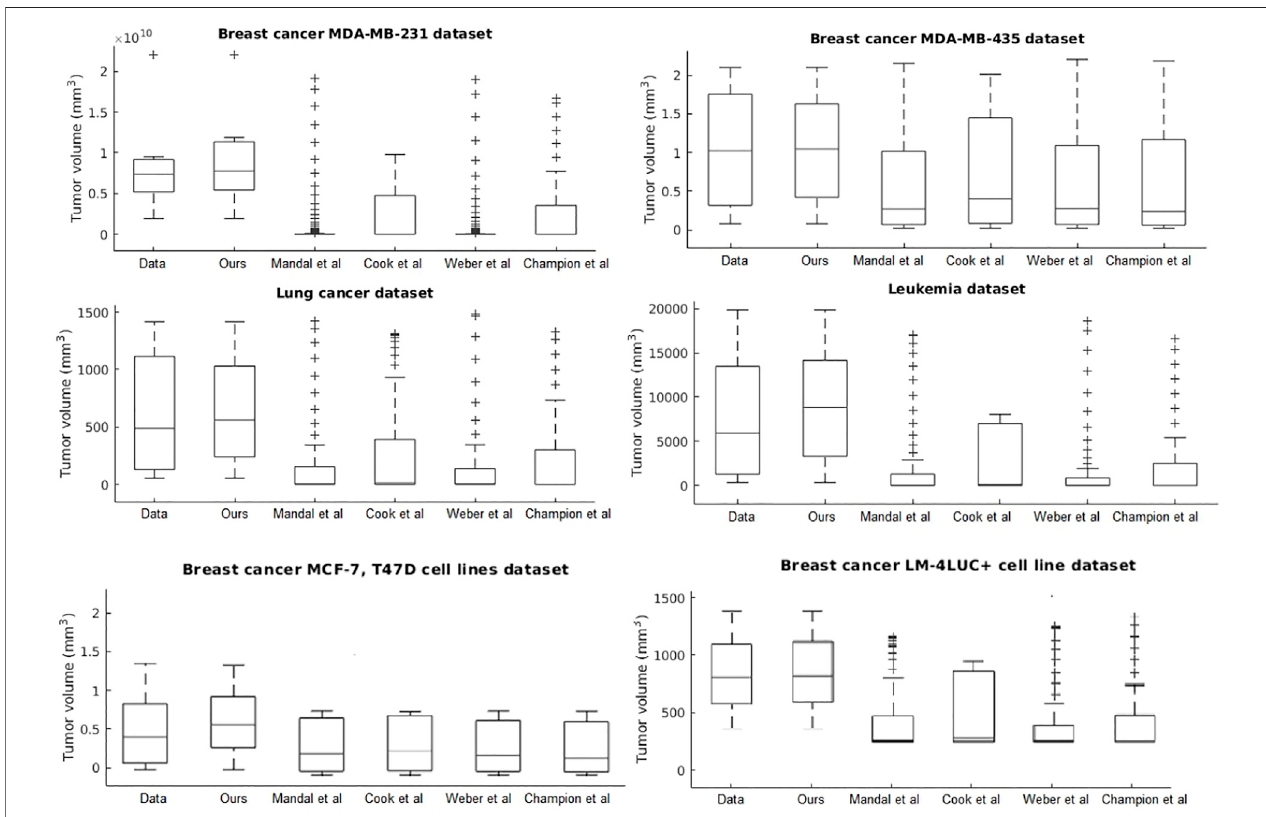
FIGURE 5 | Evaluation of the data-driven relation learning systems on tumor growth: summary